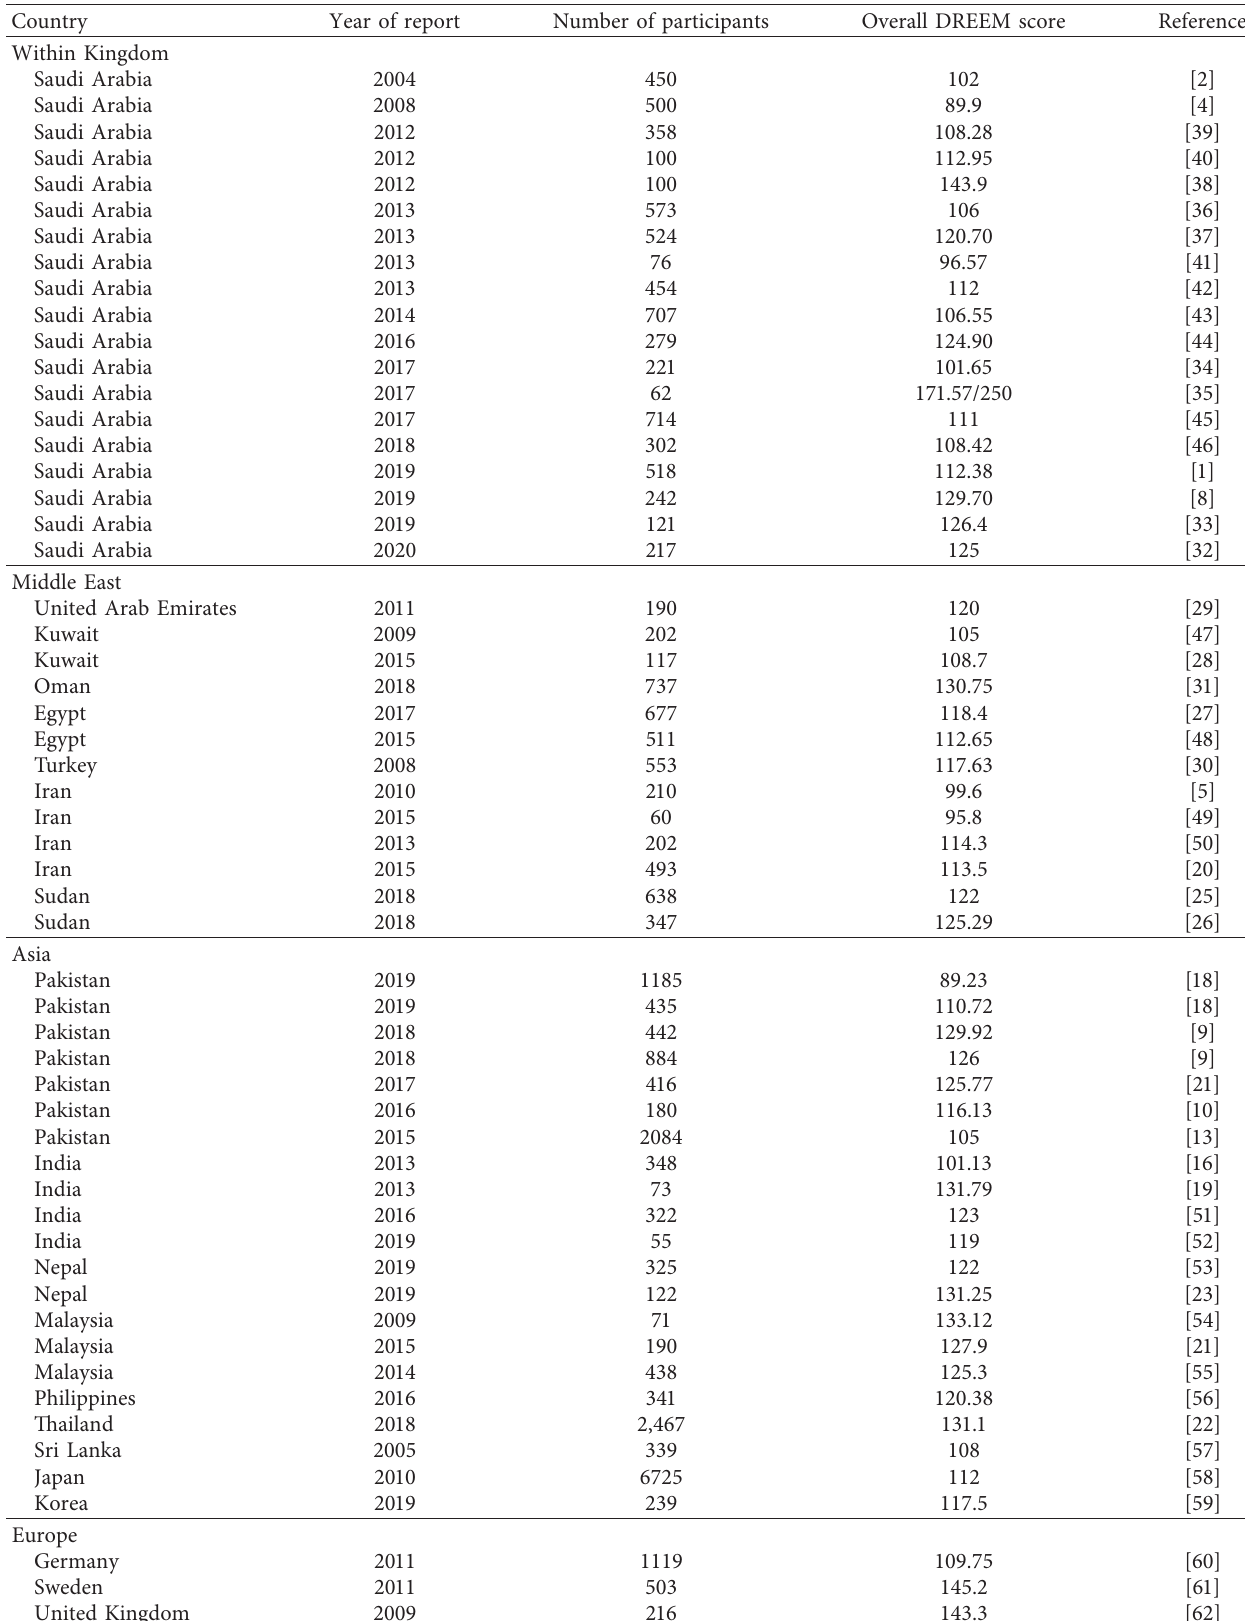
Table 1: Comparison of DREEM mean total scores of different studies in various